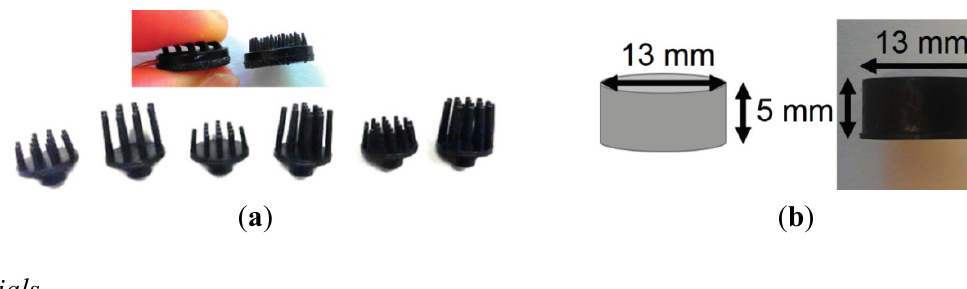
Figure 1. ( a ) Pin-shaped and ( b ) cylinder-shaped conductive polymer dry